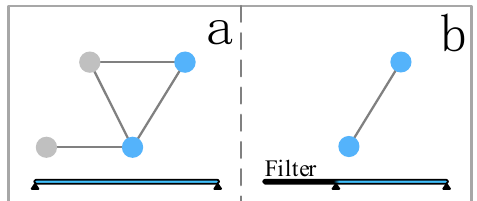
Figure 9. Diagrams of filtering interaction model based on node attributes, ( a ) nodes before filtering; ( b ) nodes after filtering.